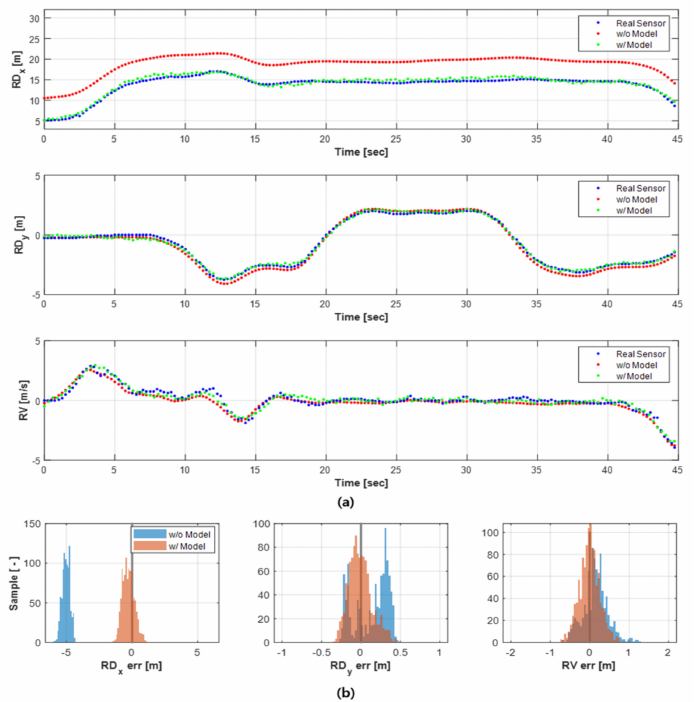
Figure 9. ( a ) Result of perception sensor modeling, ( b ) distribution of